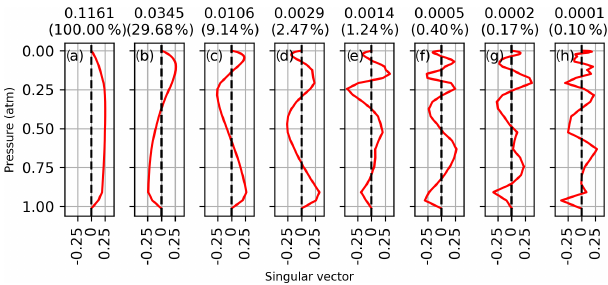
Figure D4. Same as Fig. D1 but for the Weak1 window.